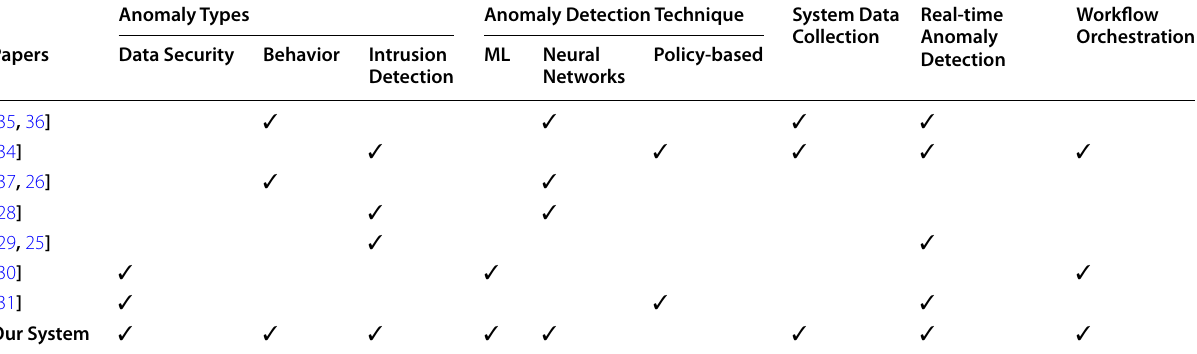
Table 1 Overview and classification of existing work on security in